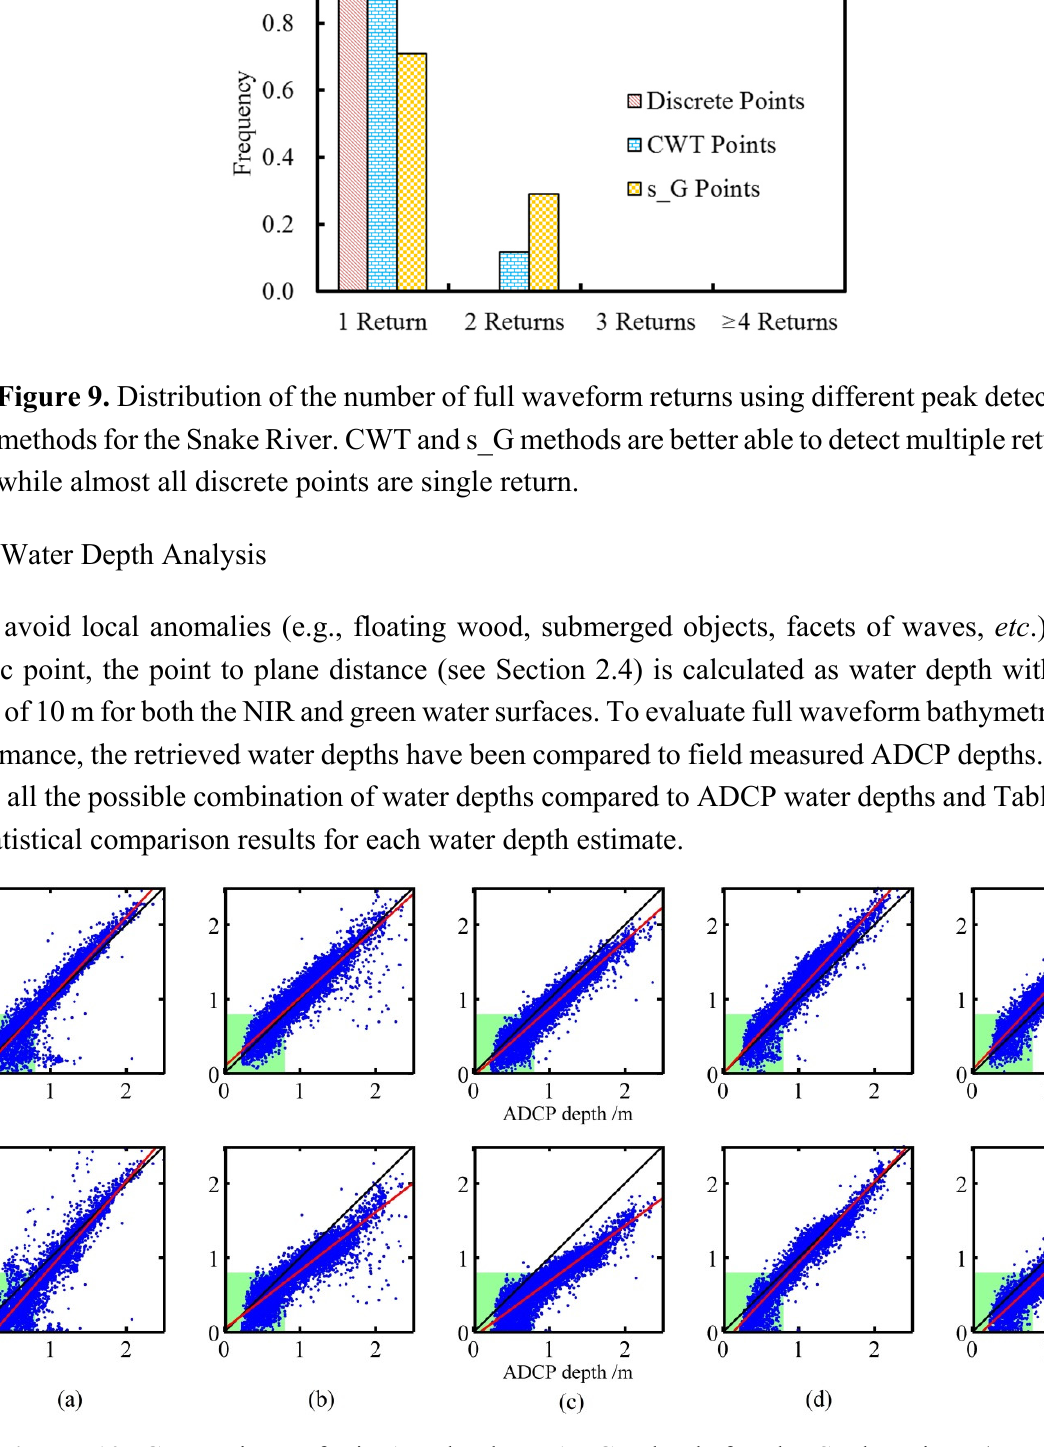
Figure 10. Comparison of LiDAR depth to ADCP depth for the Snake River (top row: LiDAR depths generated with NIR estimated water surface, bottom row: LiDAR depths with green return water surface). Black lines in the figures are the 1:1 line while the red lines are regression lines, and the green shaded areas highlight extremely shallow water (<0.8 m), ( a ) water depths from discrete points; ( b ) water depths from s_G points; ( c ) water depths from c_G points; ( d ) water depths from CWT points; and ( e ) water depths from ESR